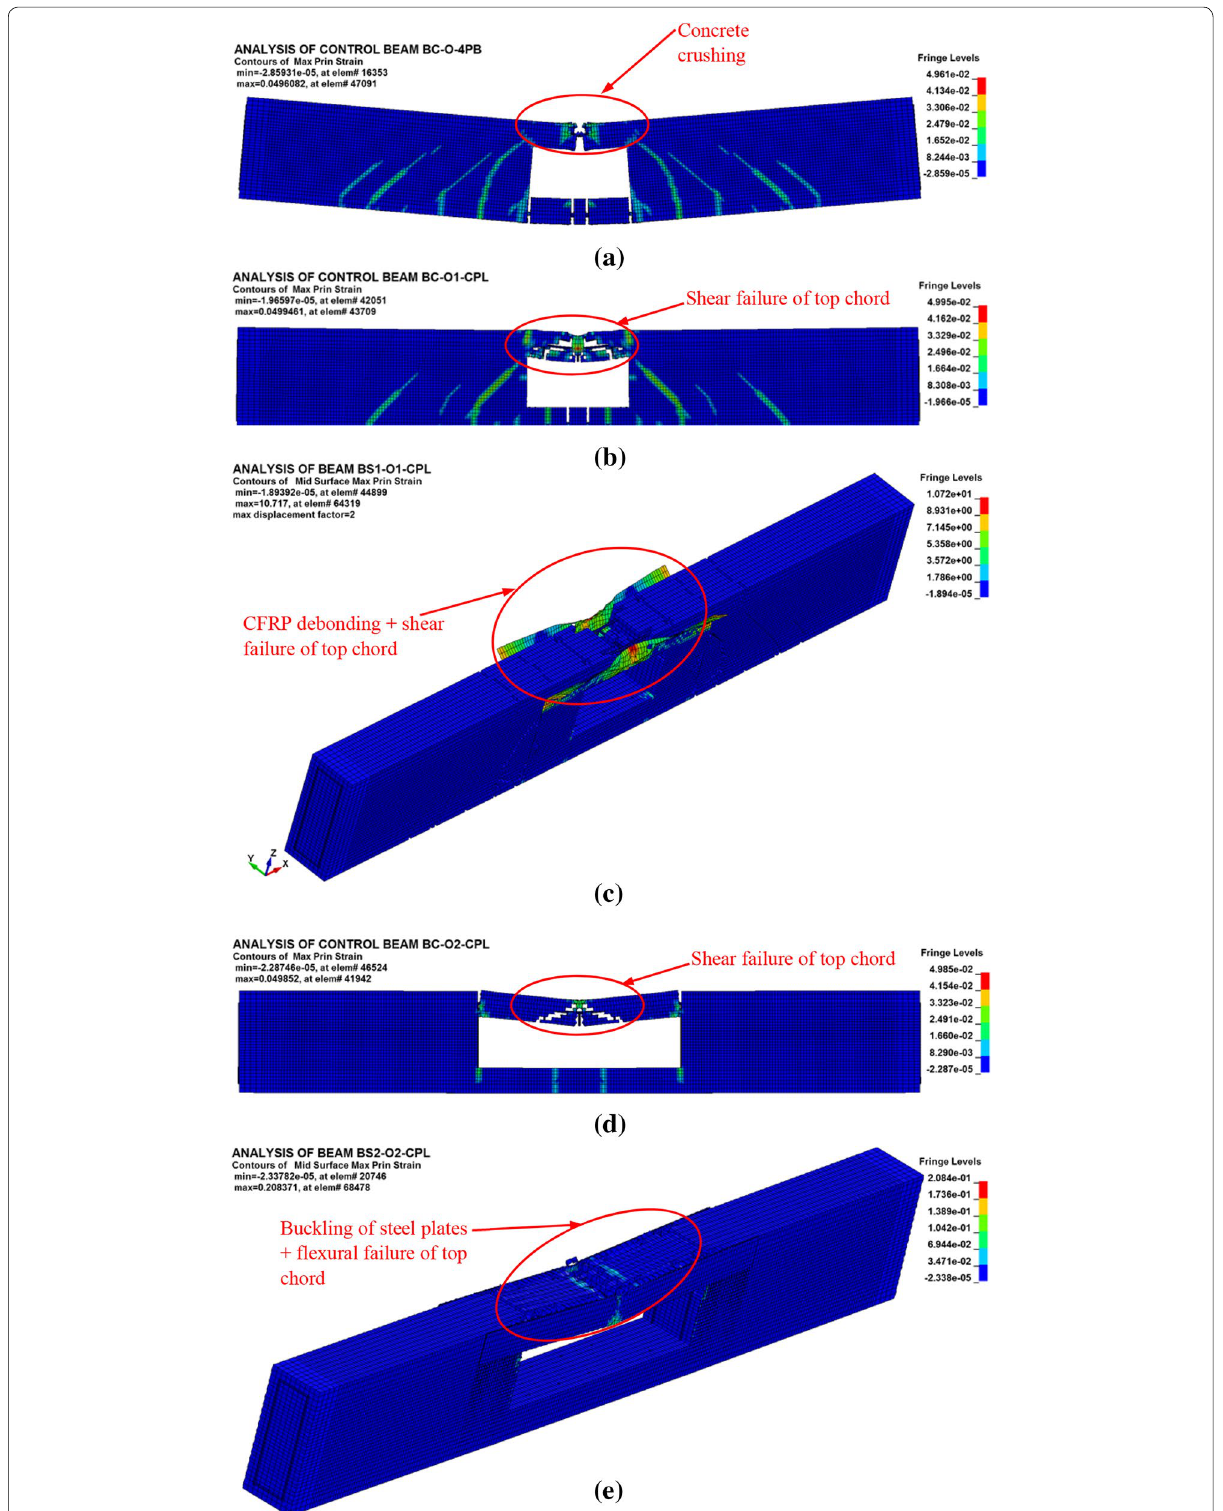
Fig. 12 FE modes of failure for: a BC‑O1‑4PB, b BC‑O1‑CPL, c BS1‑O1‑CPL, d BC‑O2‑CPL, and e